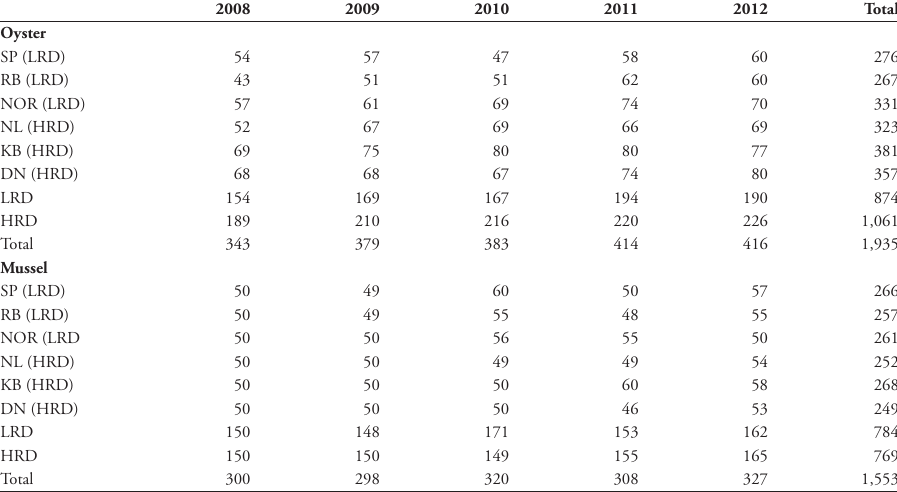
Table 1. Number of oysters and mussels used to assess individual metrics. SP = Swinnplate, RB = Rob- insbalje, NOR = Norderney, NL = Nordland, KB = Kaiserbalje, DN = Dornumer Nacken, LRD = simple reefs with low reef density, HRD = complex reefs with high reef